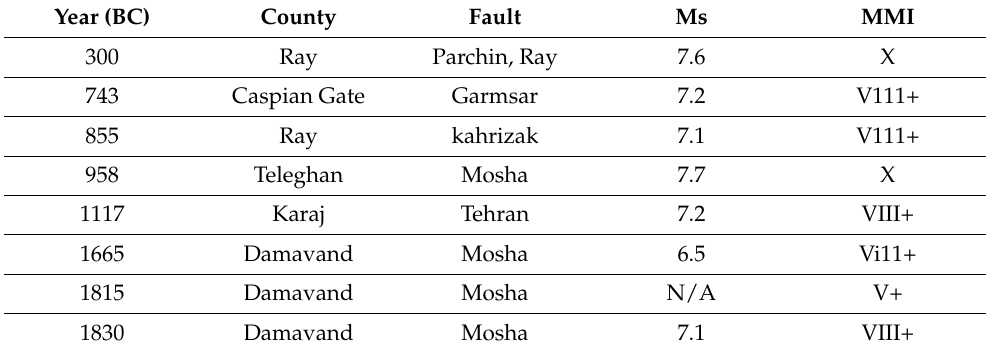
Table 1. The list of earthquakes in Iran on scales close to 7 Richter around Tehran